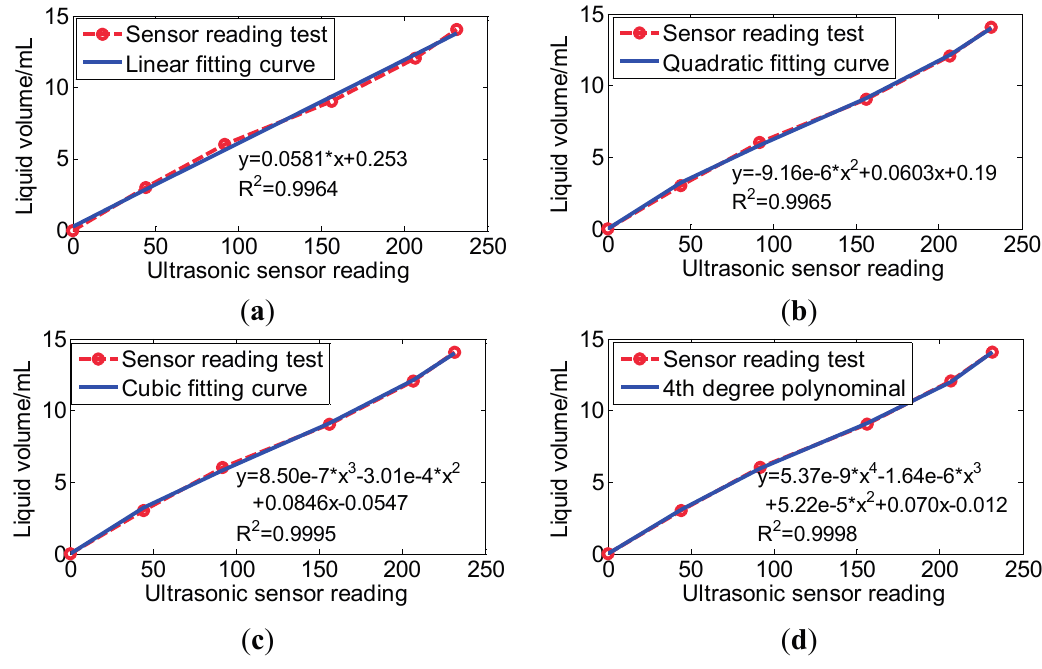
Figure 7. Fitting cure of the ultrasonic sensor calibration for liquid volume measurement. ( a ) Linear fitting curve; ( b ) Quadratic fitting curve; ( c ) Cubic fitting curve; ( d ) 4th degree polynominal fitting